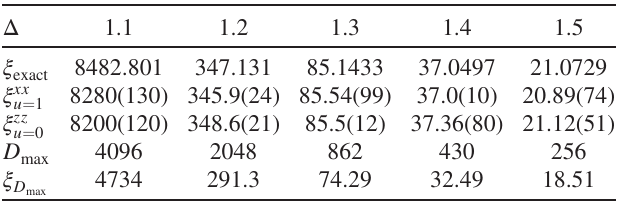
TABLE I. XXZ spin- 1 = 2 model. Comparison of the extrapo- lated correlation length with the analytical result. Correlation length is resolved by symmetry sector, where u ¼ 1 can be R Þ and u ¼ 0 with C R Þ . Additionally, we associated with C xx ð zz ð show the largest bond dimension D used for given Δ and the corresponding MPS correlation length. For those values of D the exact ground state energy is reproduced up to an error